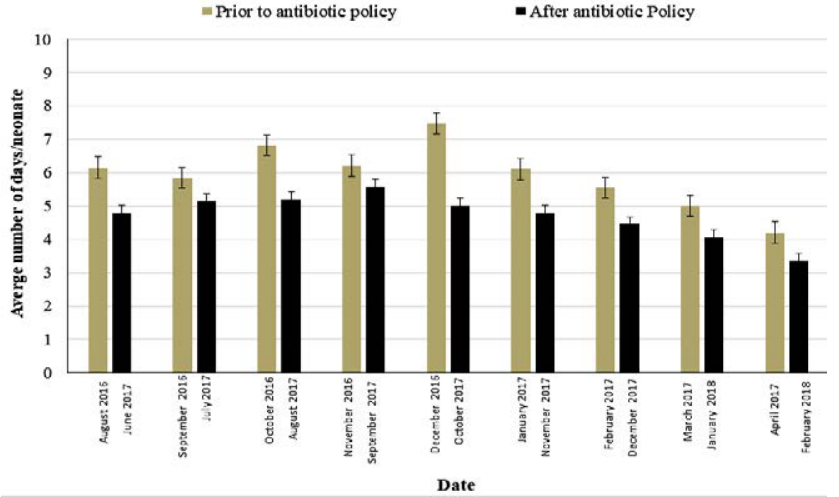
Fig. 5. Average number of neonates’ clinical days before and after the implementation of the culture- guided antibiotic policy and strict infection control